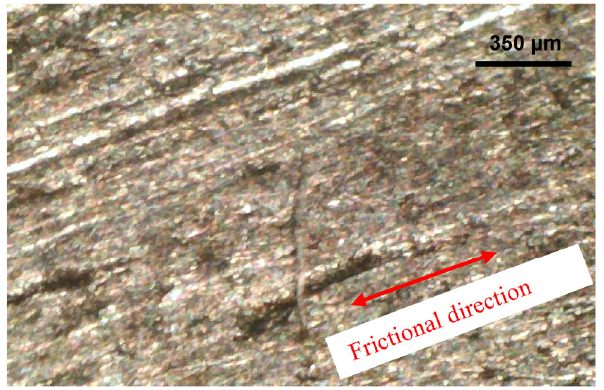
Fig. 15 Photomicrographs of the inner surface of the cylinder